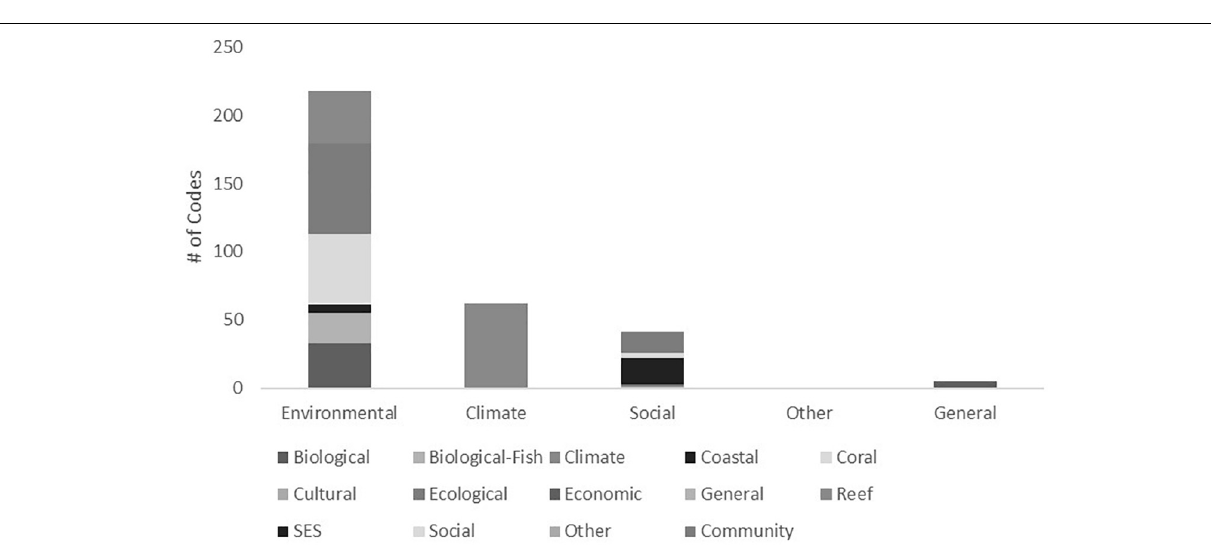
FIGURE 7 | Grouped types of resilience from all entities made in voluntary commitments of SDG 14.5. N = 133. Climate is single coded to emphasize its number and overall importance to entities. Data collected from https://oceanconference.un.org/commitments/ as of September